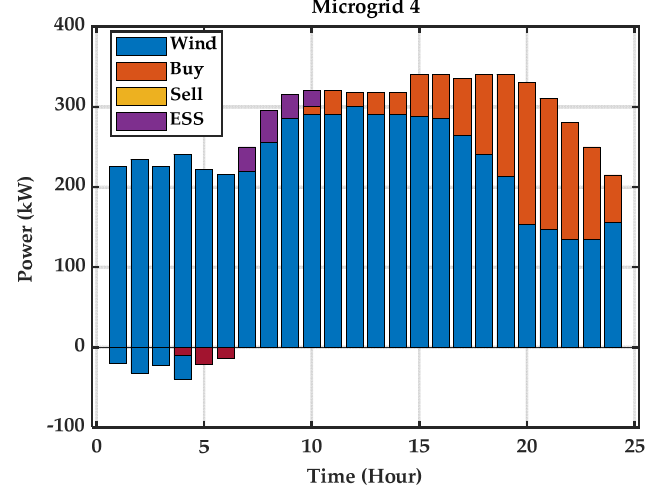
Figure 12. Load profile of MG4.